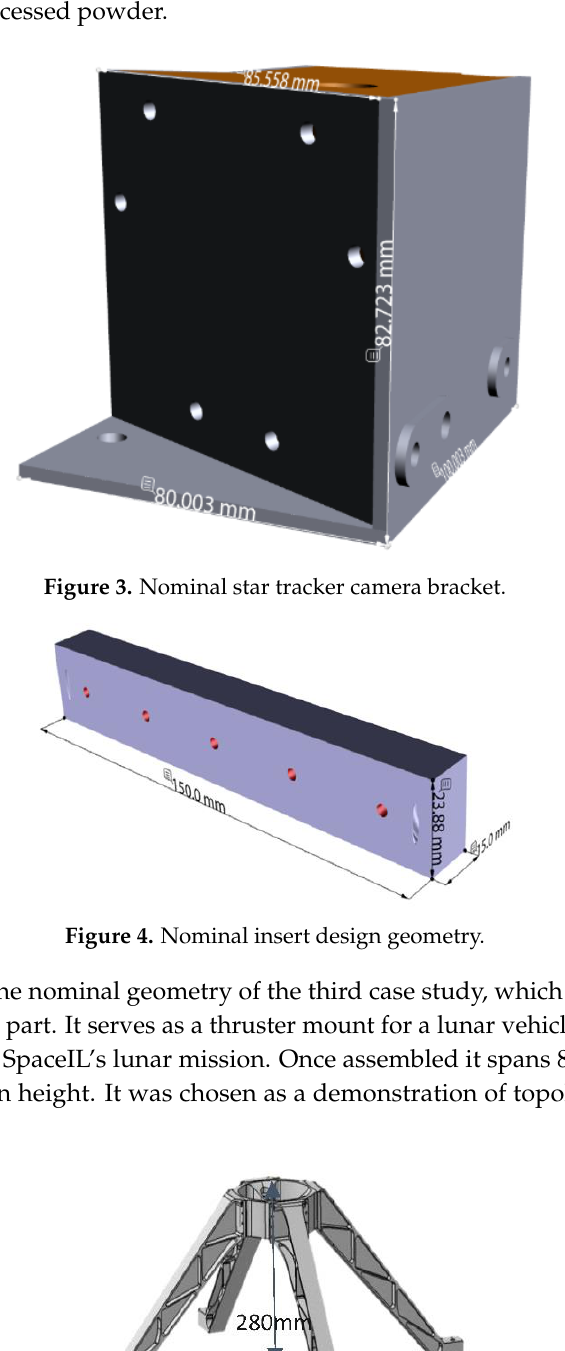
Figure 4. Nominal insert design geometry.